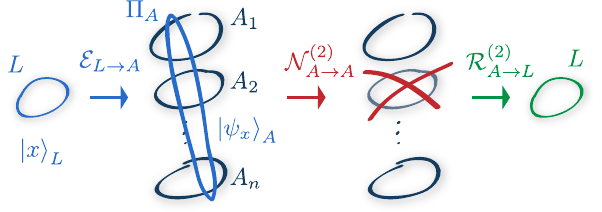
FIG. 3. A code E maps a logical state j x i on an abstract L → A logical space L to a state j ψ on a physical system A . Here, we x i A consider a physical system composed of several subsystems A ¼ A 1 ⊗ A 2 ⊗ (cid:3) (cid:3) (cid:3) A . The code space, with associated projec- n tor Π , is the range of the encoding map. The environment acts by A erasing a subsystem A , represented as a noise channel N ð i Þ . A i A → A good error-correcting code is capable of recovering the original logical state j x i from the remaining subsystems, by applying a recovery map R ð i Þ . In our analysis, we assume that the A → L and that i is known, so that the recovery map may depend on i . The quality of the code is characterized by how close the overall process (erasure followed by recovery) is to the identity process acting on the logical system, as measured by either the (fixed- input) entanglement fidelity or the worst-case entanglement